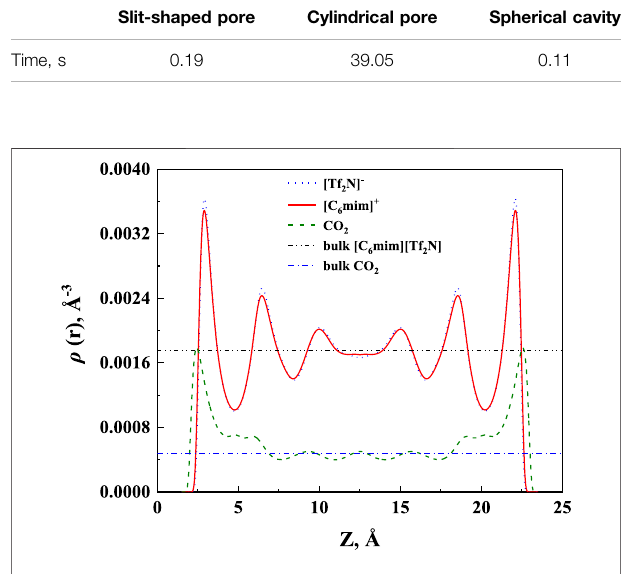
FIGURE 3 | The calculated density pro fi les of [C 6 mim] [Tf 2 N]-CO 2 system con fi ned in 25 Å slit silica pore at 10 bar and 323.15 K.